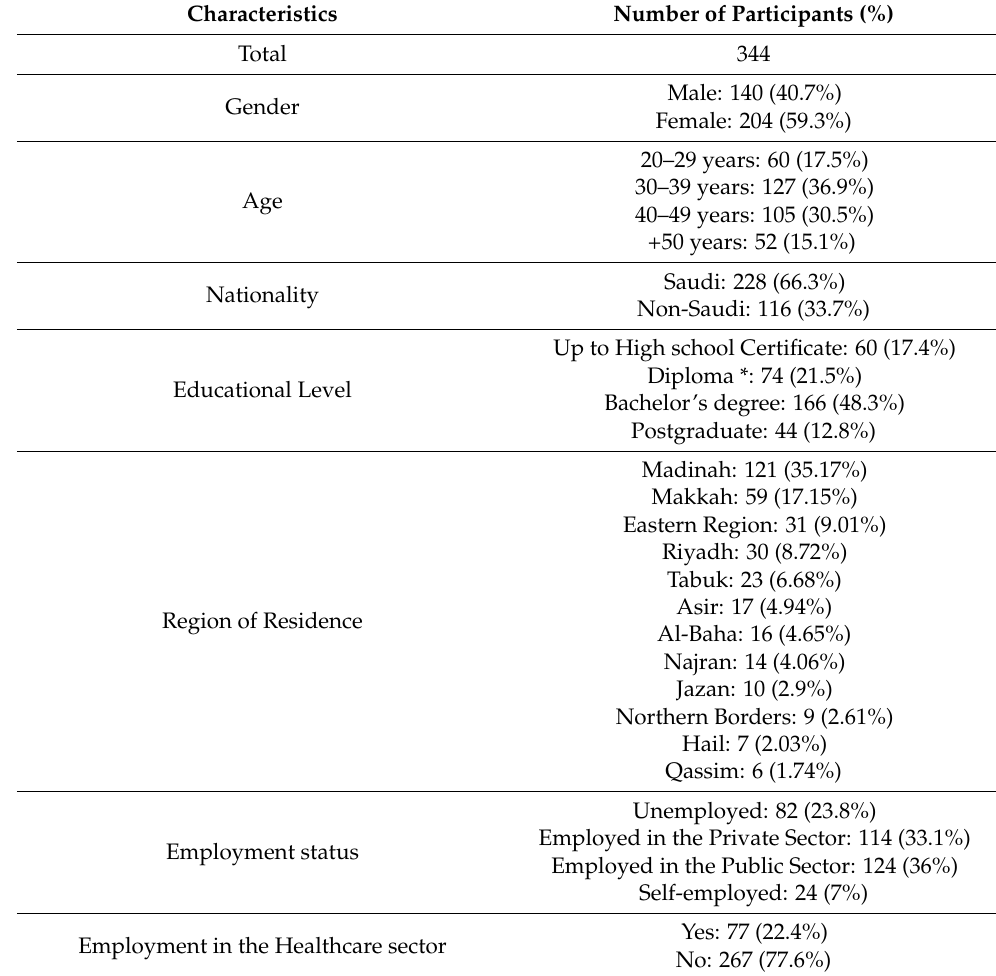
Table 1. Characteristics of the study